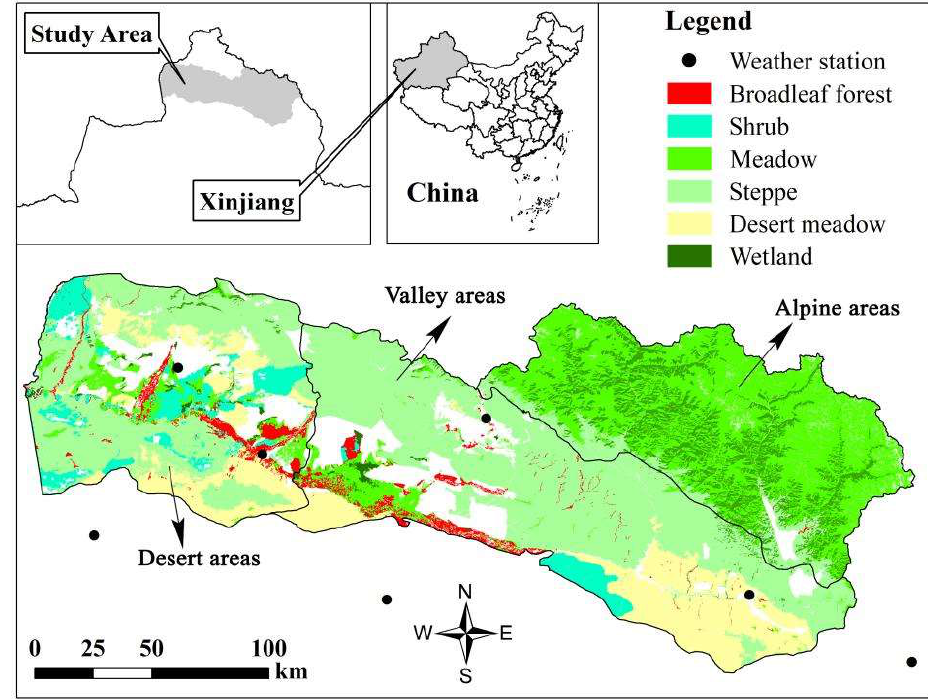
Figure 1. Geographical location of study area. According to the difference of the altitude, vegetation, the study area was divided into the alpine areas, valley areas and desert areas. The National Meteorological Stations are shown in the figure.